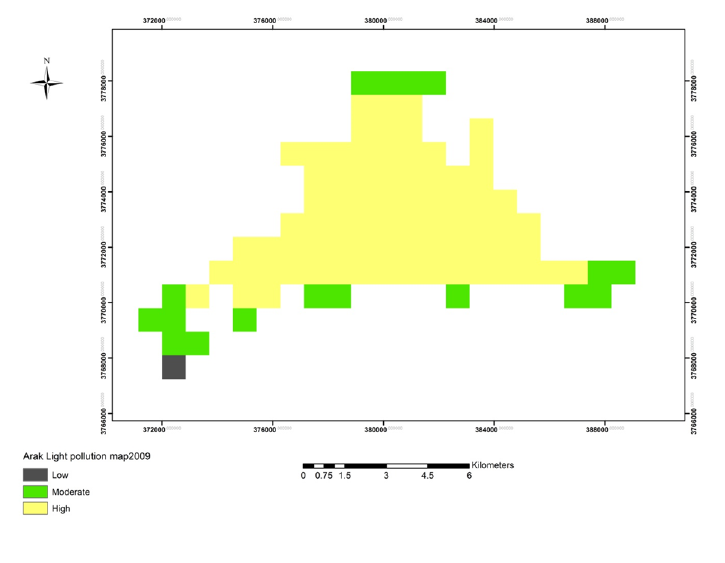
Figure 1. Light pollution map 1997